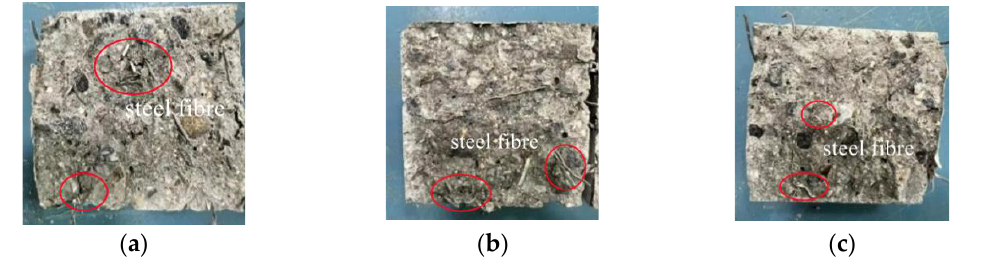
Figure 12. Structural internal morphology of S – BF – RC concrete. ( a ) S 1.5 BF 3.5 RC. ( b ) S 1.5 BF 5.5 RC. ( c ) S 1.5 BF 7.5 RC. ( c ) S 1.5 BF 7.5 RC.